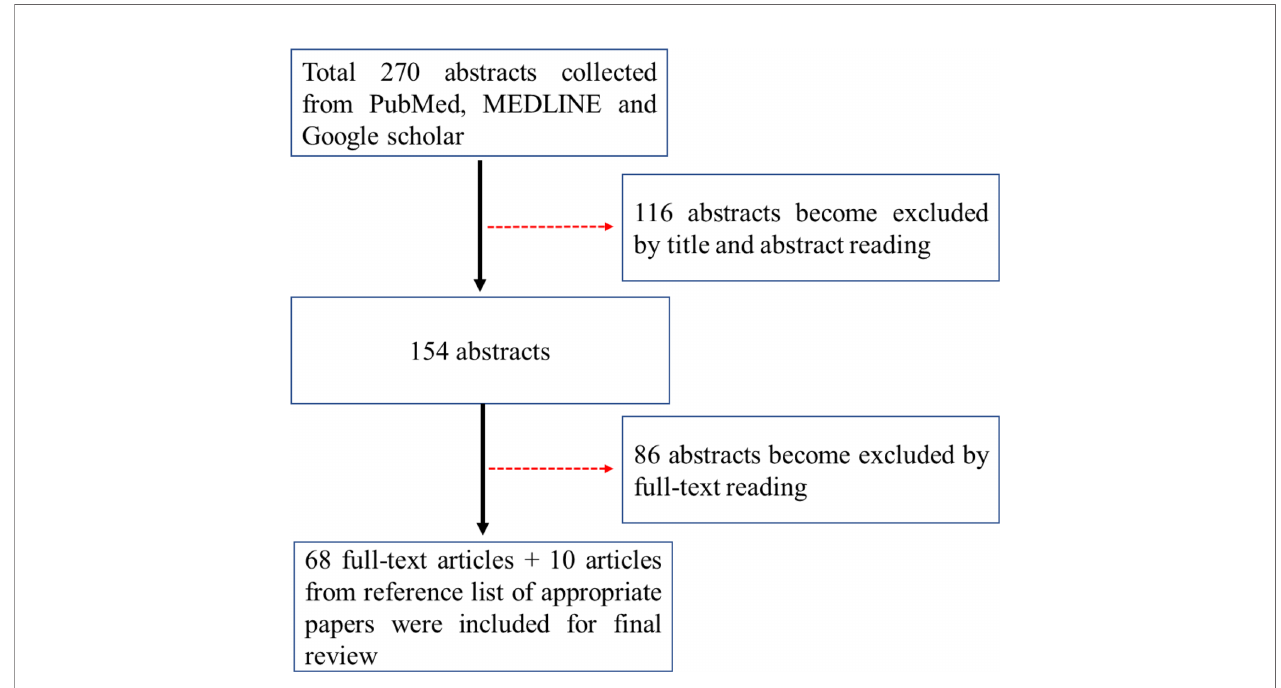
FIGURE 1 | Prisma fl ow chart for the search of the